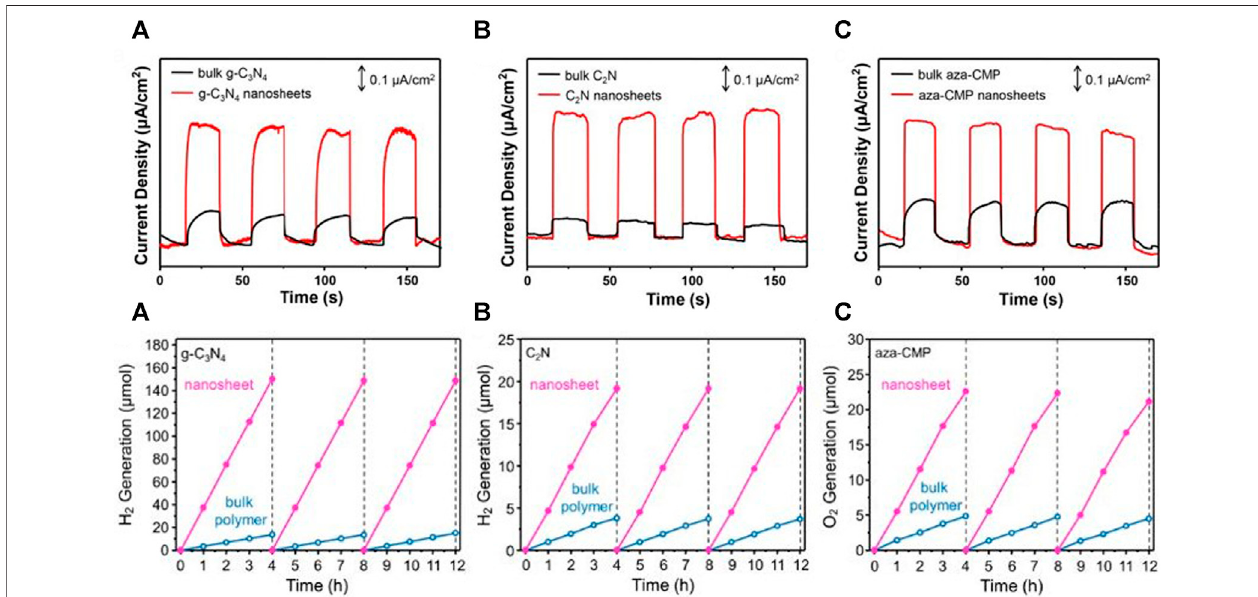
FIGURE 6 | (Top panel) Transient photocurrent response of bulk (A) g-C3N4 (under full spectrum irradiation), (B) C 2 N and (C) aza-CMP [under visible light irradiation ( > 420 nm)] and corresponding nanosheets (Bottom panel) . Typical time course of photocatalytic H 2 or O 2 production using bulk polymers and corresponding exfoliated nanosheets as photocatalysts. Reproduced with permission from Zhang et al. (2019).